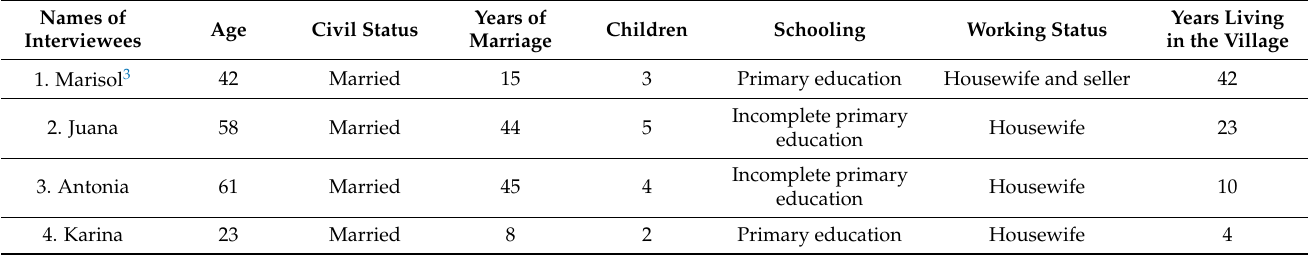
Table 1. Profiles of